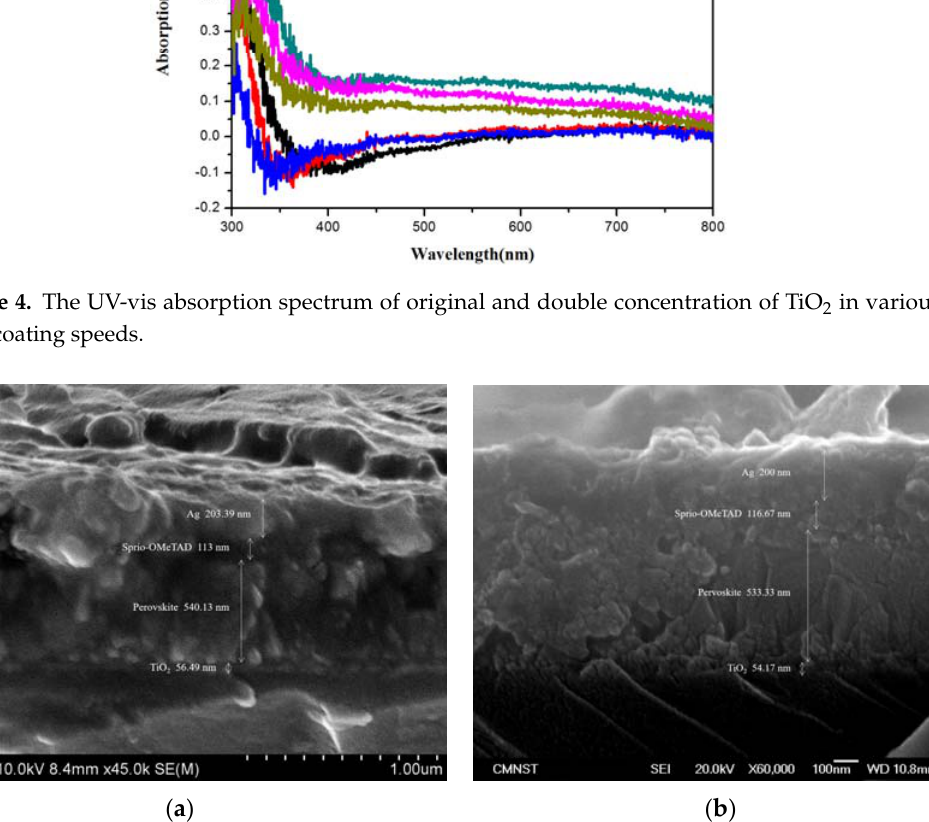
Figure 5. The cross-section images of SEM with ( a ) rotate and ( b ) zero angle for optimized PSCs Figure 5. The cross ‐ section images of SEM with (a) rotate and (b) zero angle for optimized PSCs obtained by DC TiO 2 obtained by DC TiO 2 ETL.